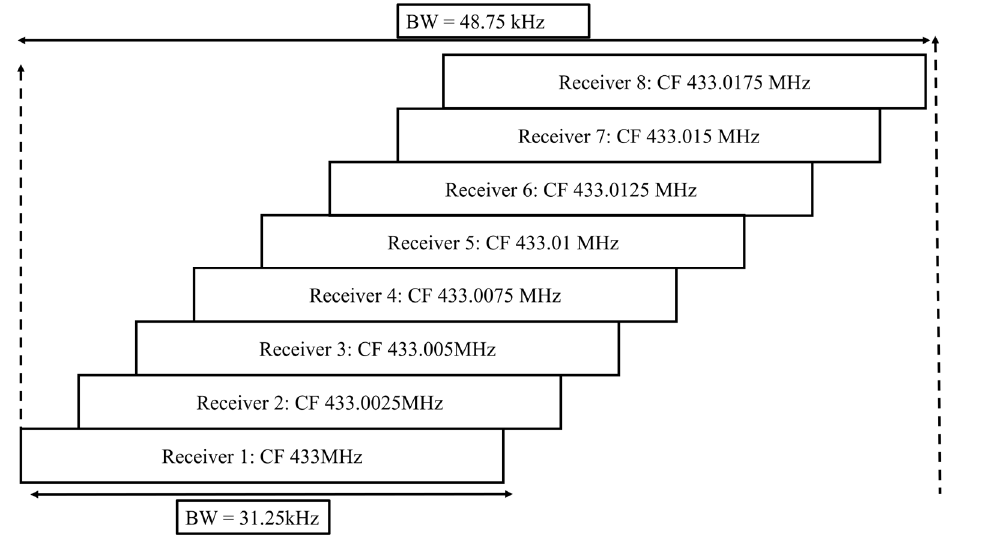
Figure 21. Passive Doppler correction method on ‐ orbit.